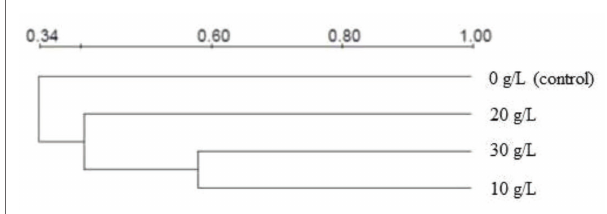
FIGURE 5 | Clustering analysis for evaluating the similarity between microbial communities at different NaCl